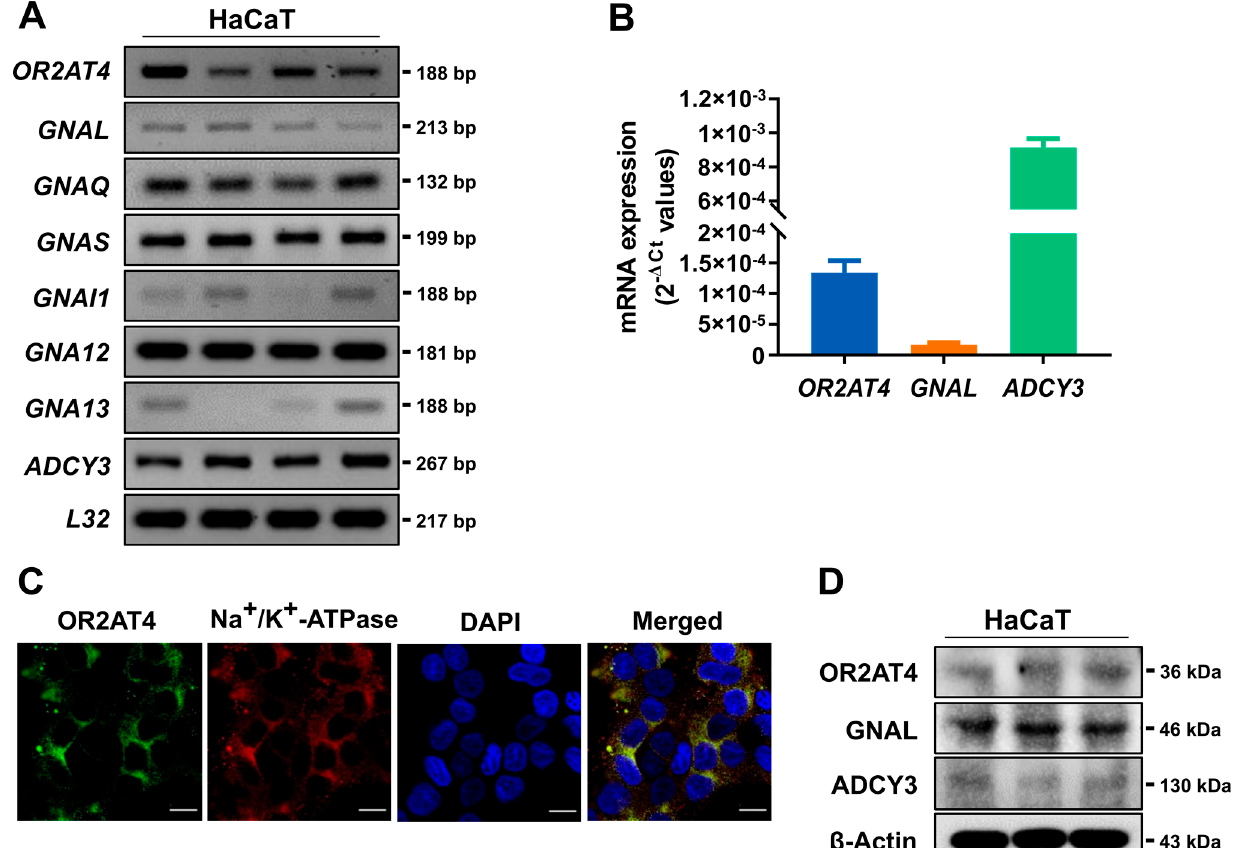
Figure 1. Ectopic expression of OR2AT4 in HaCaT human keratinocytes. ( A ) mRNA expression of OR2AT4 , GNAL , and ADCY3 in HaCaT cells by RT-PCR. Experiments were done in tetraplicate. ( B ) The mRNA expression of OR2AT4 , GNAL , and ADCY3 in HaCaT cells by real-time qPCR. ( C ) Representative images of immunocytochemical staining of OR2AT4. OR2AT4 (red) and Na + /K + -ATPase, a plasma membrane marker (green): the merged image (yellow) shows colocalization of Na + /K + -ATPase and OR2AT4 in the plasma membrane. Scale bar, 20 µm. ( D ) Immunoblot analysis of the membrane fraction of HaCaT cells. Experiments were done in triplicate. Quantification data are means ± standard error of mean (SEM).